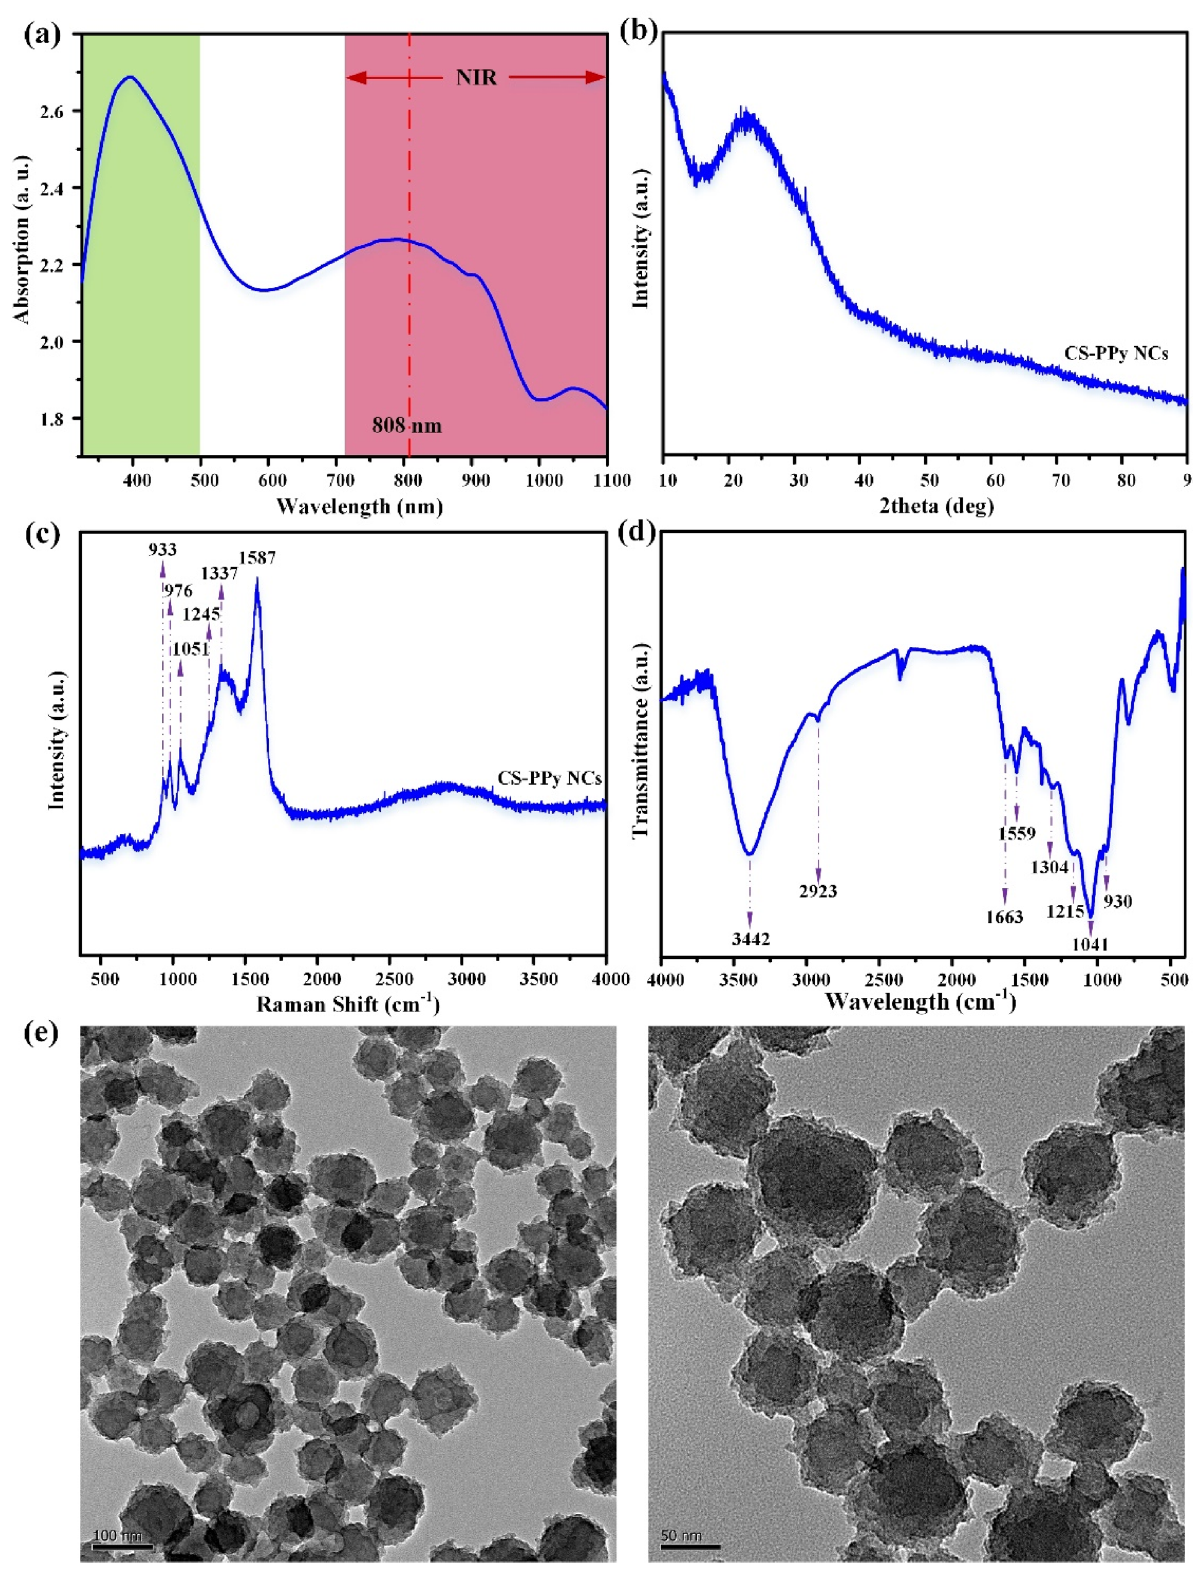
Figure 2. Characterization of CS–PPy NCs ( a ) UV–Vis–NIR absorbance spectrum CS–PPy NCs dispersion in water. ( b ) XRD patterns of CS–PPy NCs. ( c ) Raman spectrum of CS–PPy NCs. ( d ) FTIR spectrum of CS–PPy NCs. ( e ) FE-TEM image of CS–PPy